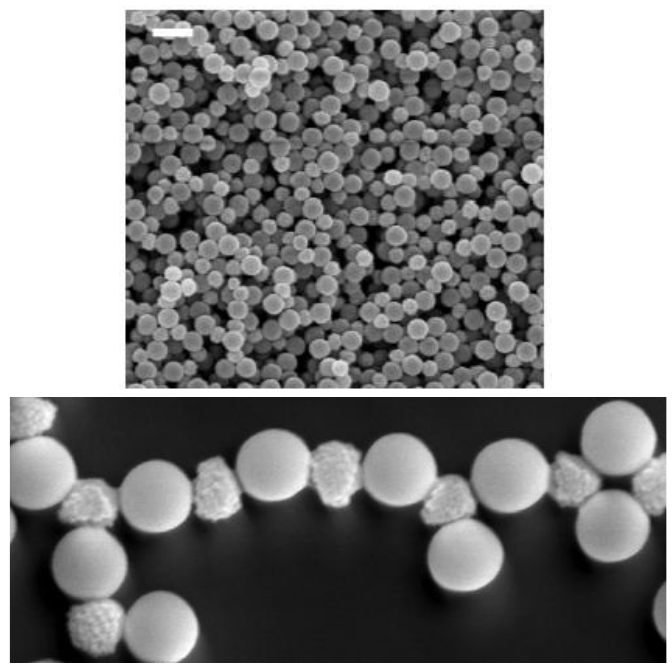
Figure 1. Porous microgel-latex heteroaggregate. The scale bar in the top image denotes 1 μm (reproduced with permission from reference